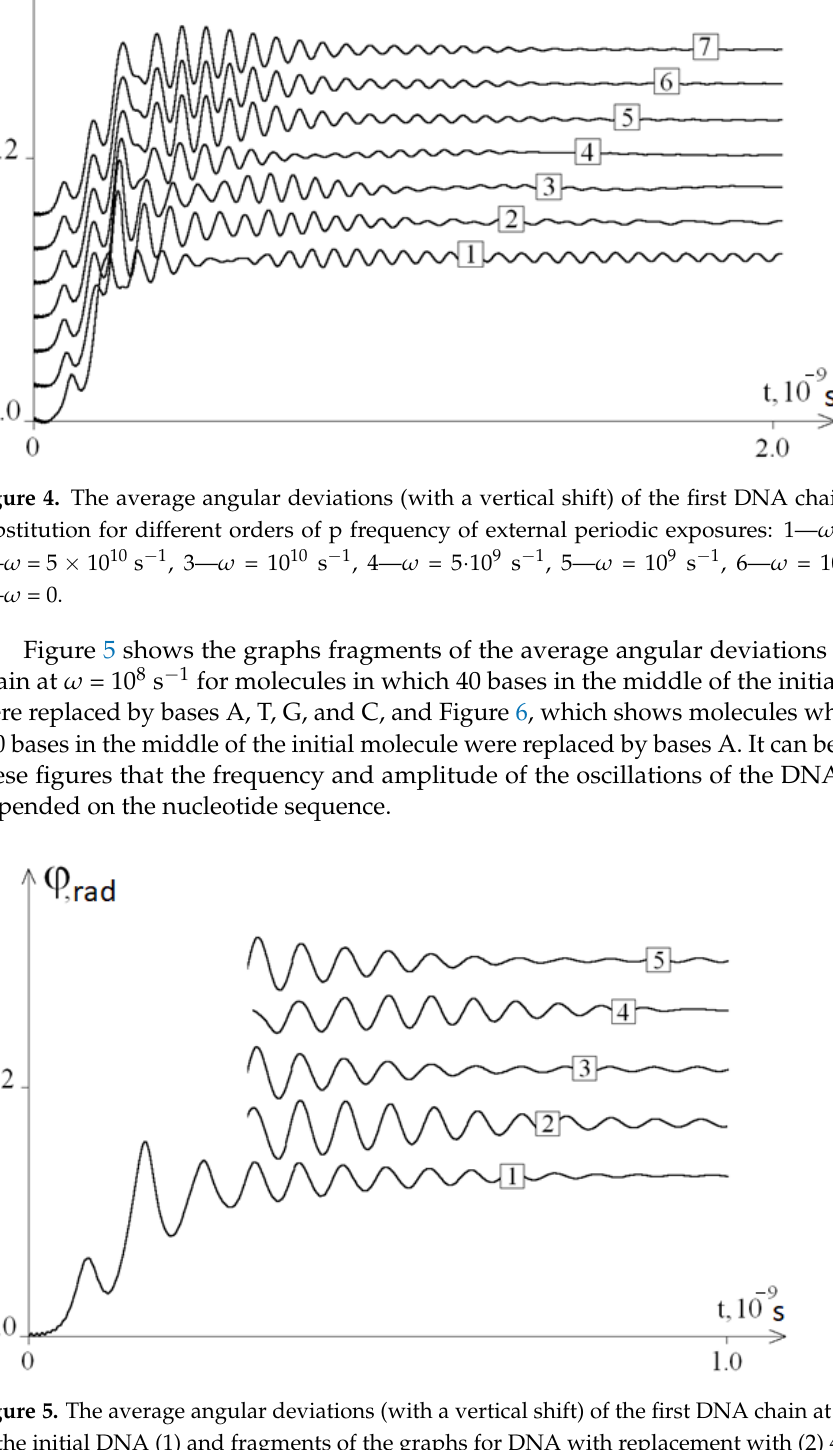
Figure 3. Graph of the angular deviations of the first DNA chain with 40A substitution at ω = 10 11 s – 1 .